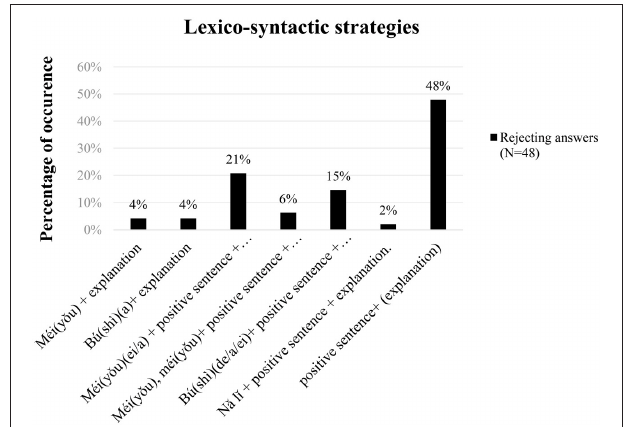
FIGURE 2 | Percentage of occurrence of the various lexico-syntactic strategies used by MC speakers in the REJECT condition.